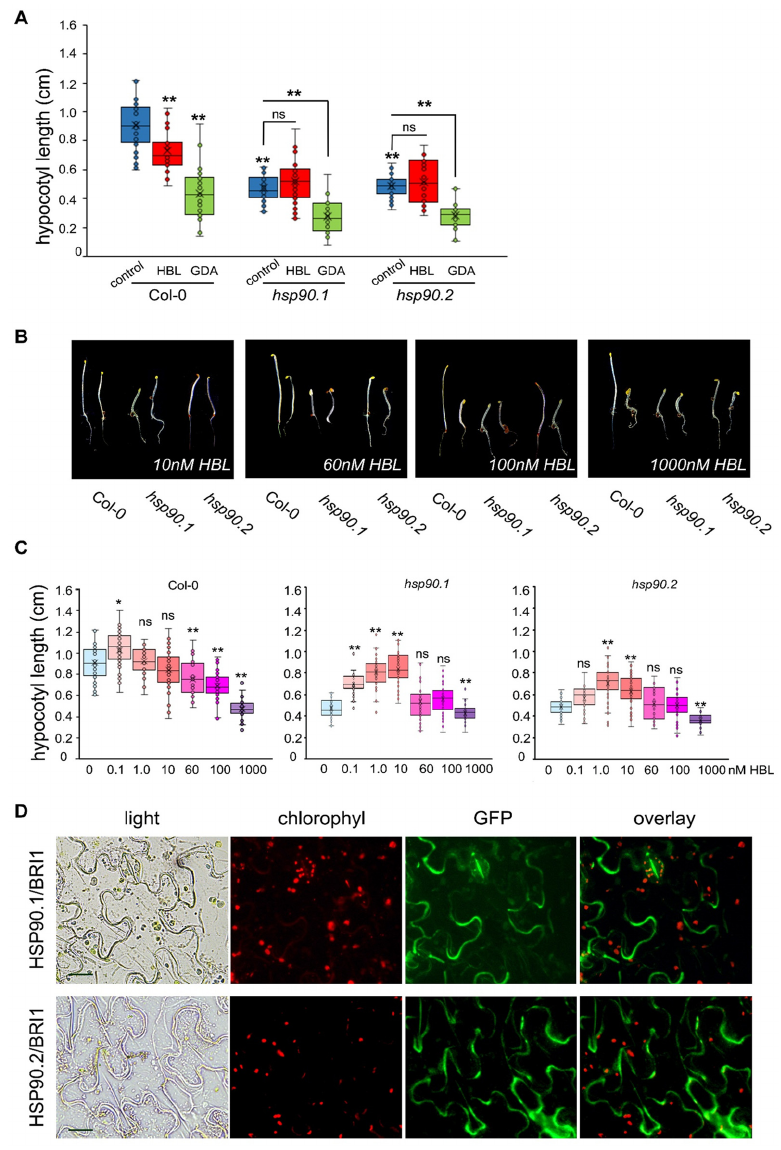
Figure 1. HSP90 is required for hypocotyl elongation. ( A ) Hypocotyl lengths sensitivity assays of 5-day-old etiolated Col-0, hsp90.1, and hsp90.2 , seedlings grown in the presence of 60 nM HBL or 2 µ M GDA. ( B ) 5-day-old hsp90.1 and hsp90.2 seedlings grown in different concentrations of HBL. Left plant of each pair of seedlings shows growth under control conditions and right upon treatment with HBL. ( C ) Hypocotyl length sensitivity assays in 5-day-old etiolated Col-0, hsp90.1, and hsp90.2 seedlings grown on a gradient of HBL concentrations. In box plots the middle line in the box represents median, the × shows mean, the bottom line depicts the 1st quartile, while the top line describes the 3rd quartile; the vertical lines (whiskers) extend to the minimum and maximum value within the 1.5 × interquartile range (distance between the 1st and the 3rd quartile); points outside of the whiskers mark outliers (values outside of the 1.5 × interquartile range). Data were analyzed by one-way ANOVA followed by Tukey’s test for multiple comparison (*): p < 0.05, (**): p < 0.01, ns: non-significant (n ≥ 30). In graph ( A ), the significance between the Col-0 at control conditions and the other treatment, Col-0 and hsp90.1 or hsp90.2 as well as between the control conditions of hsp90 mutants and treatments are indicated. In graph ( C ), the significance between control conditions and treatments is presented for each genotype. ( D ) In vivo interactions between BRI1 and HSP90.1 or HSP90.2 were confirmed by BiFC assays in tobacco leaf epidermis Scale bars, 20 µ